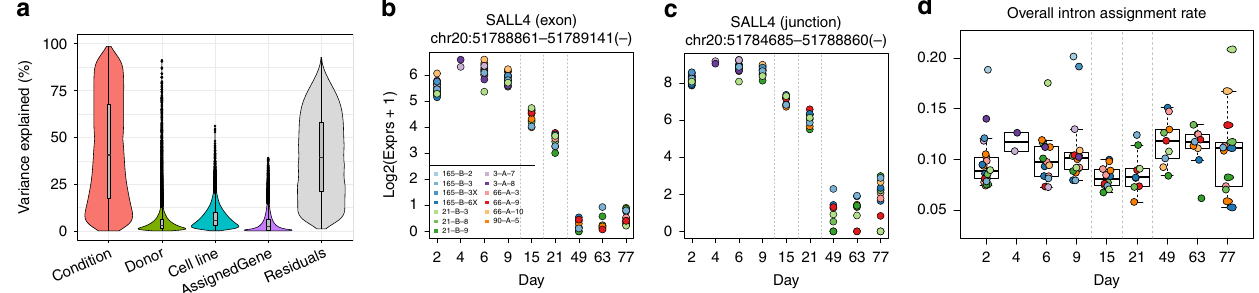
Fig. 3 Feature-level differential expression. a The contribution of variance in expression models at the gene level. b An example of a differentially expressed exon across conditions from SALL4 , a gene thought to play a role in the development of motor neurons, as well as expression of the neighboring exon – exon junction ( c ). d Percent of aligned reads assigned to intronic sequences across all samples and timepoints, with a signi fi cant overall gain in intronic assignment rate between NPCs/rosettes (days 15 and 21) and differentiated neurons (days 49 – 77) in line with previous